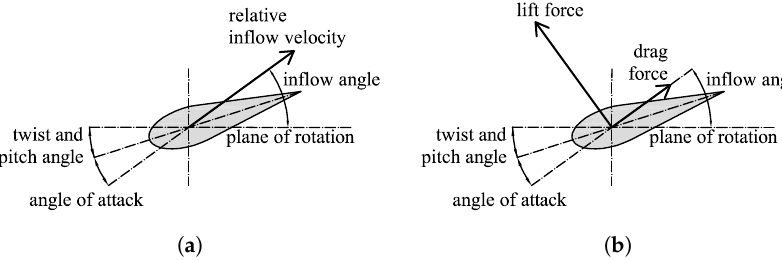
Figure 7. Schematic representation of ( a ) an aerofoil exposed to the relative inflow velocity resulting from the wind speed, the rotor speed and the structural motion, and ( b ) the resulting lift and drag forces acting on that